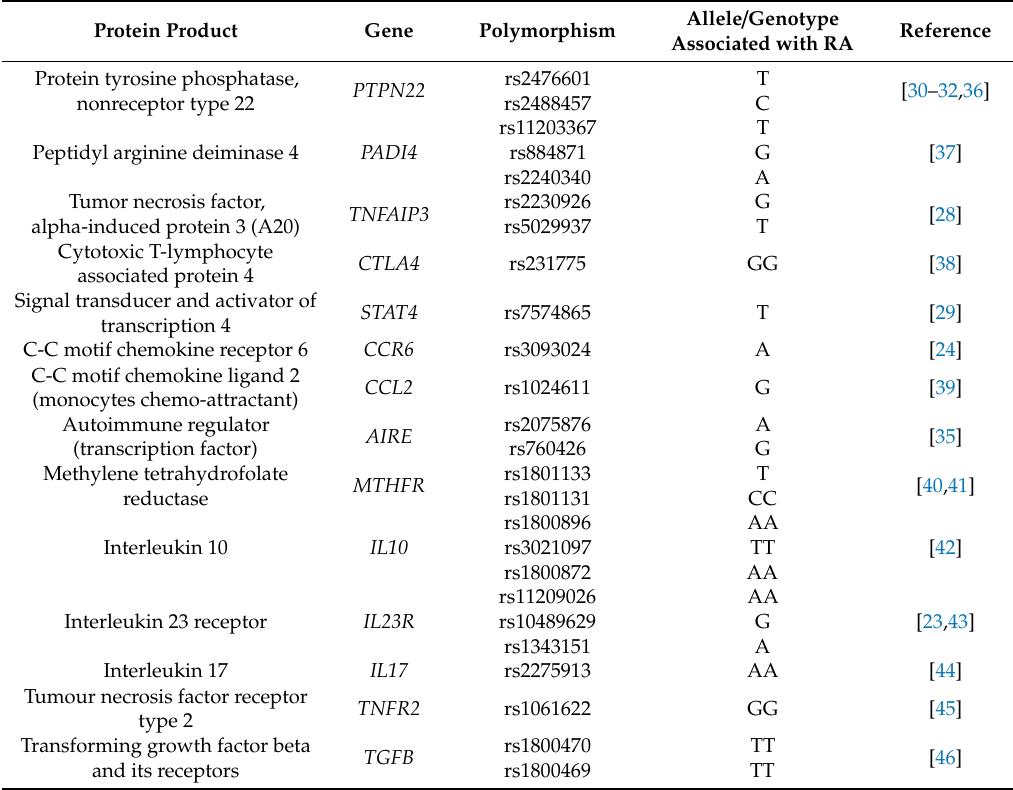
Table 1. Polymorphisms (non-HLA genes) associated with rheumatoid arthritis (RA) in mixed populations according to meta-analyses